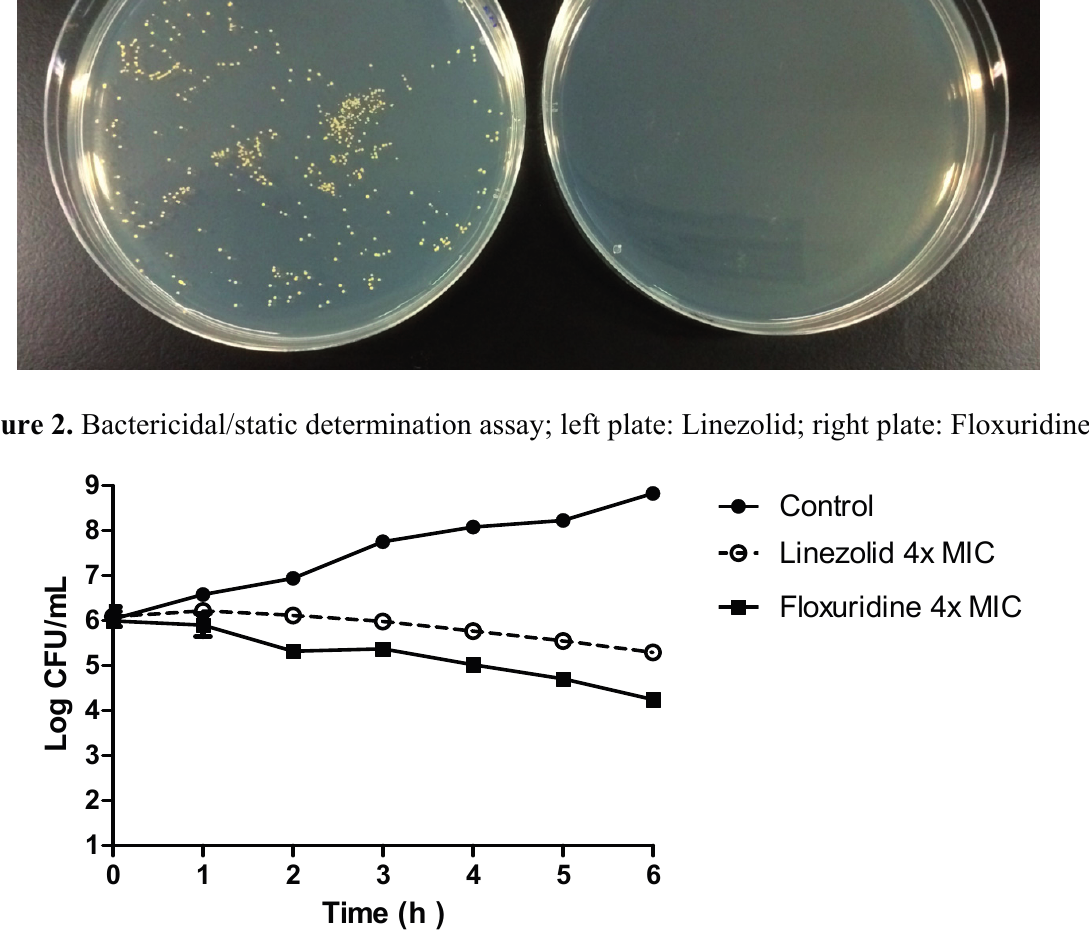
Figure 3. Time-kill assay of Linezolid and Floxuridine at 4× MICs using MRSA USA